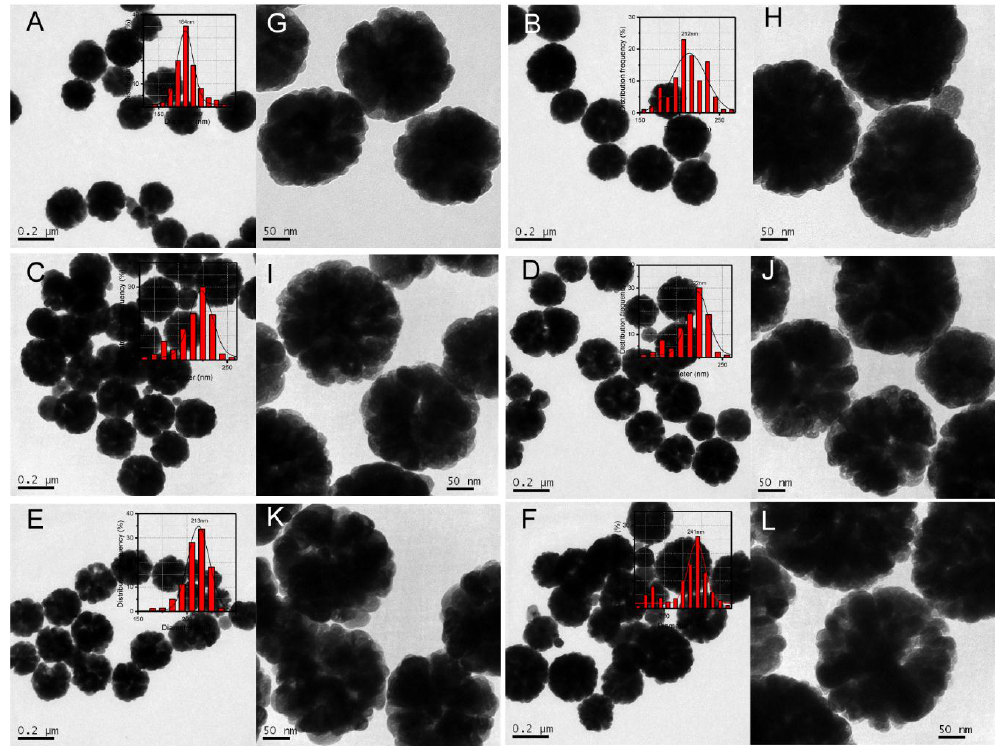
Figure 10. TEM images and size analysis patterns of Fe 3 O 4 with different reaction time, ( A ) 5, ( B ) 6, ( C ) 8, ( D ) 10, ( E ) 12, ( F ) 20 (h); the insets are the corresponding size distribution patterns. ( G – L ) is the corresponding magnification images respectively.